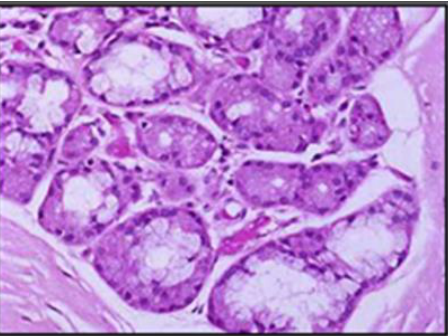
Figure 4. Microscopic appearance of an excretory duct from the submandibular gland in adults (H&E) with periodontal diseases.